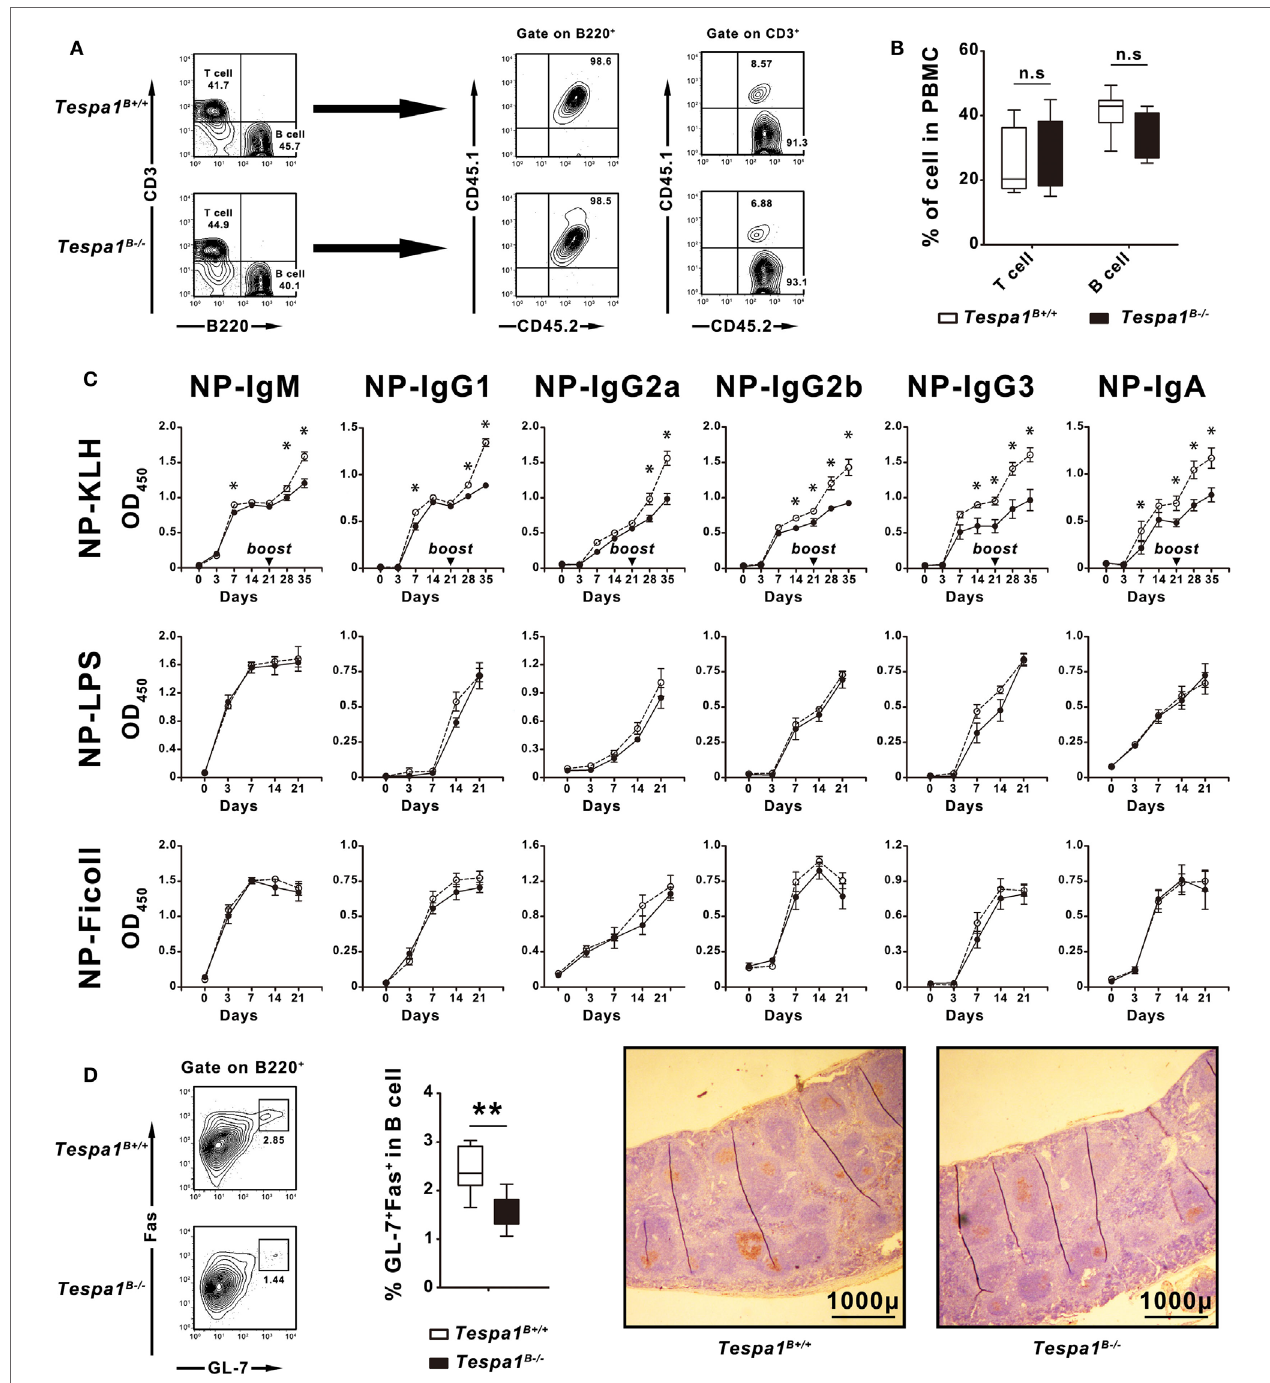
FigUre 3 | Selective impairment of T cell-dependent responses in Tespa1 -deficient chimeras. Chimeric mice reconstituted with mixed bone marrow suspensions were generated as described in Section “Materials and Methods.” (a) Peripheral blood mononuclear cells (PBMCs) of chimeric mice examined by FACS to identify the origin of the reconstituted lymphocytes. In chimeric mice, 100% of the B cells originate from CD45.1 + CD45.2 + donors, whereas more than 90% of the T cell populations originate from CD45.1 − CD45.2 + μ MT mice. (B) Percentages of T and B cells in PBMCs of Tespa1 -deficient and wild-type (WT) chimeras. (c) NP-specific serum Ig levels in Tespa1 -deficient and WT chimeras at different time points after immunization (on day 0) with NP-KLH, NP-LPS, or NP-Ficoll. (D) (Left) Splenocytes from Tespa1 -deficient or WT chimeras immunized with NP-KLH were stained with anti-B220, anti-Fas (CD95), and anti-GL-7 antibodies. Cells were gated on the B220 + population. (Right) Immunohistochemical staining with peanut agglutinin (brown) of spleens from control and Tespa1 -deficient chimeras collected on day 21 after immunization. Scale bar, 1,000 µm. Summarized data shows the mean ± SEM from three separate experiments ( n = 10 mice per group), * p < 0.05, ** p < 0.01.